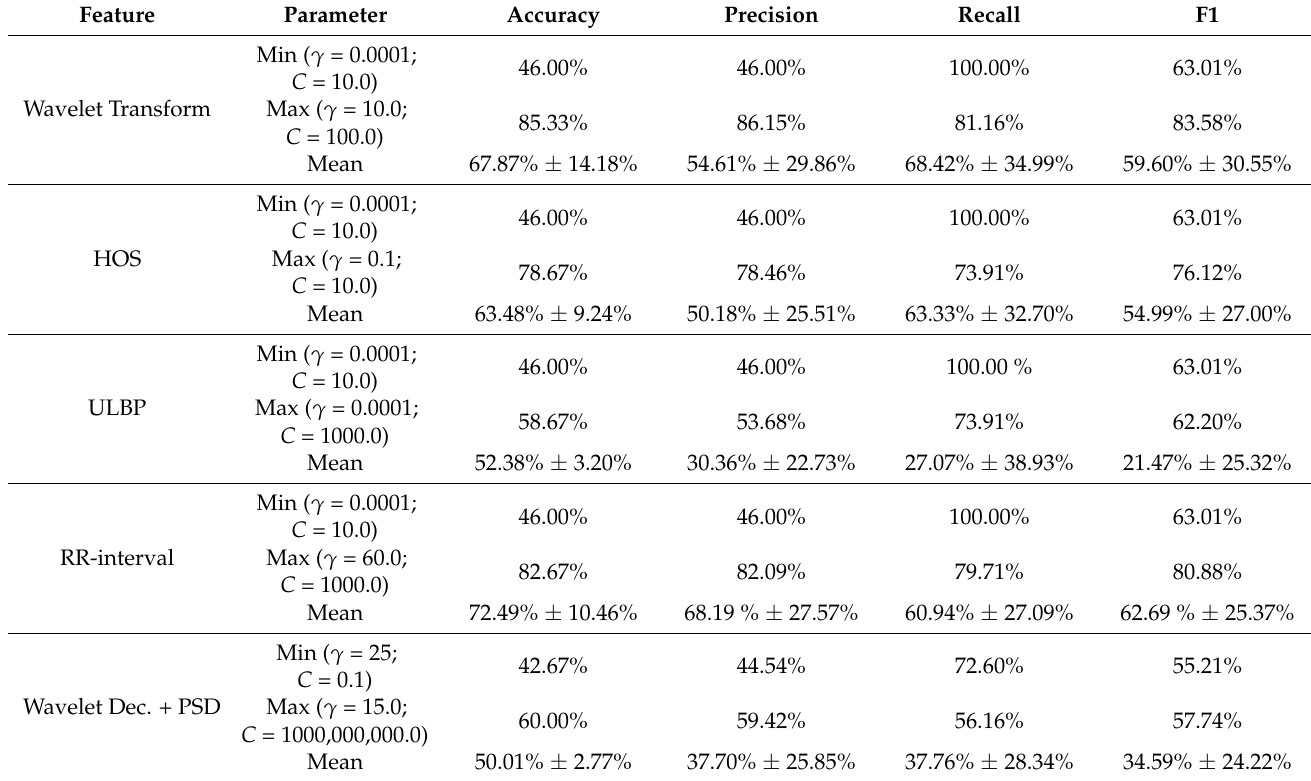
Table 3. Results obtained with single handcrafted features for the